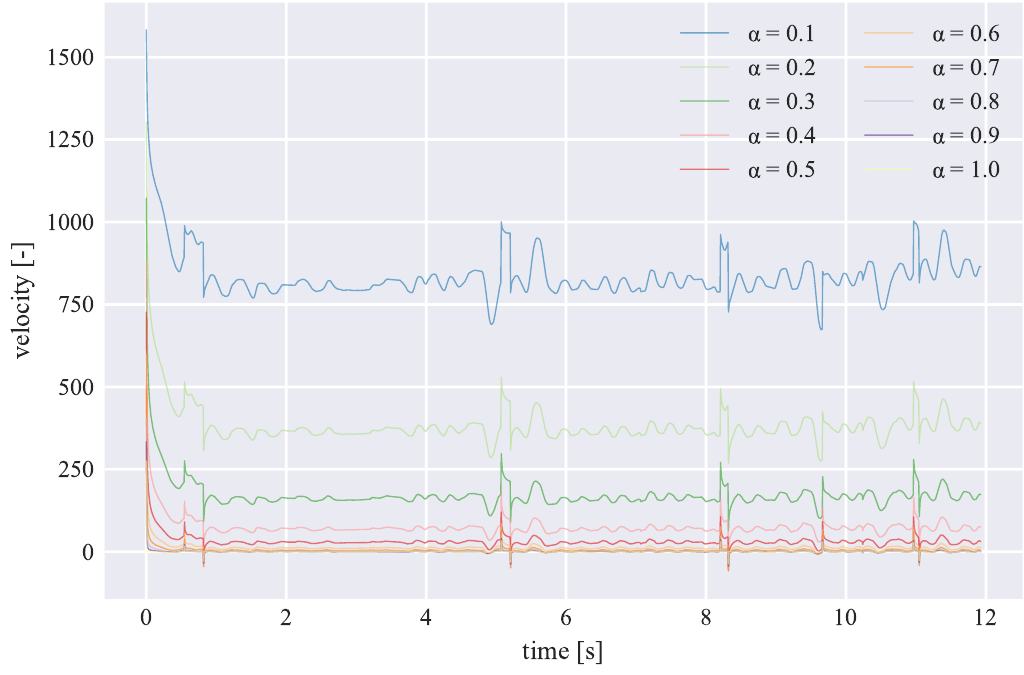
Figure 4. Vertical velocity patterns of the sentence task for different orders of fractional-order derivatives